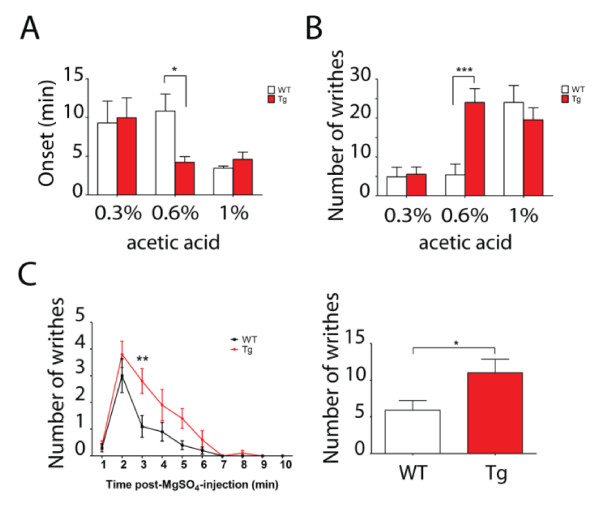
Visceral hyperalgesia in transgenic mice induced by visceral stimulation of acetic acid or magnesium sulfate. A-B. The onset (A) and the total number of writhes (B) during a period of 15 minutes were determined after i.p. injection of 0.3%, 0.6%, 1% acetic acid (n = 7-10). 0.6% acetic acid resulted in a shorted onset and increased number of writhes in transgenic (Tg) mice. C. Induction of visceral pain induced by magnesium sulfate (12 mg/k g, i.p.). Tg mice displayed an increase of writhes in response to magnesium sulfate during a period of 10 minutes (mean ± s.e.m., n = 10, *p < 0.05, **p < 0.01, ***p < 0.001).